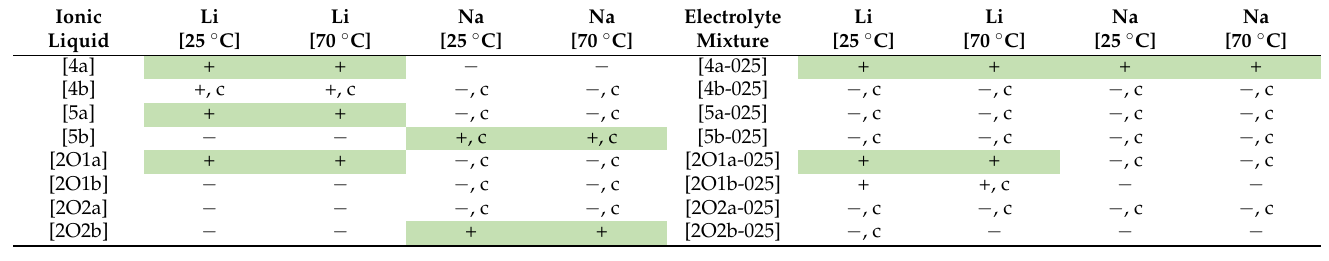
Figure 2. Images of the stored electrolytes (28 d) over lithium metal at 25 °C. a = [TFSI] ‐ , b = [FSI] ‐ . Table 2. Compatibility with alkali metals within two weeks (visible degradation). Following signs are used: “+”: metal remains stable without visible degradation; “c”: electrolyte with change of color; “ ‐ ”: metal with surface modification and/or strong electrolyte reaction. Recognized changes are only visible modifications of the metal and/or liquid solution.